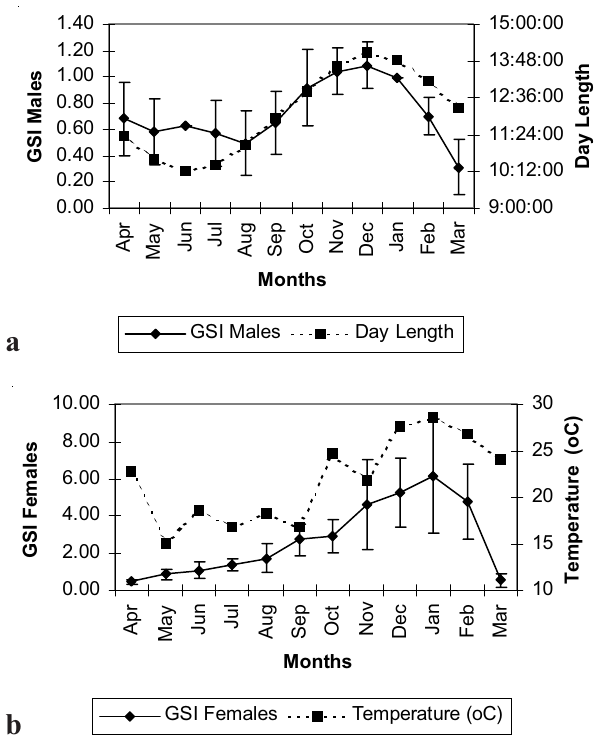
Fig. 1. Monthly variation of the mean values of GSI (± SD) in males (a) and females (b) of Aphyocharax anisitsi collected from April 2001 to March 2002 in the arroio do Salso, Rosário do Sul, RS, Brazil, and monthly variation of the day-length (a) and water temperature (b) mean values. (GSI = Gonadosomatic Index; SD = Standard Deviation represented by vertical bars).